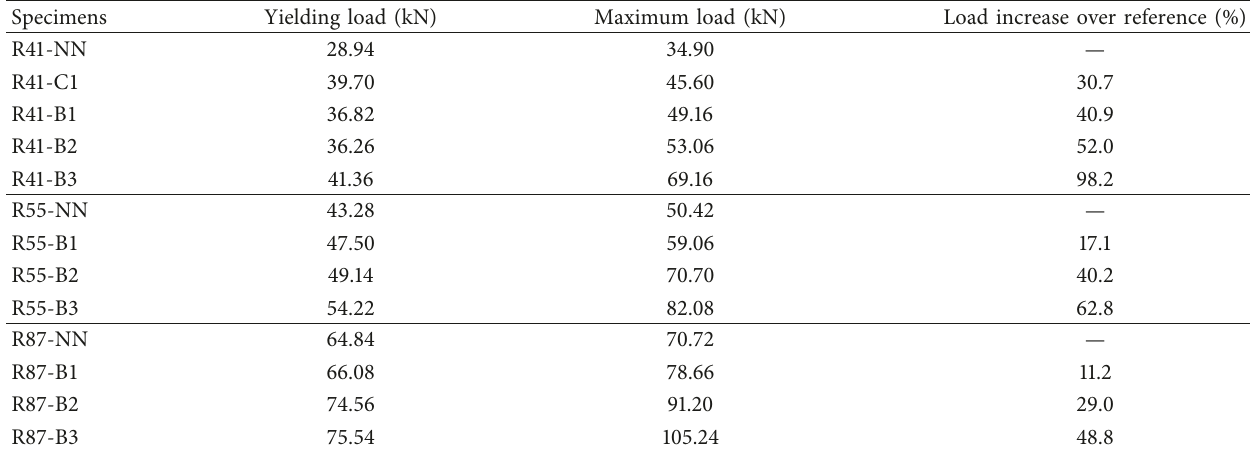
Table 5: Summary of test